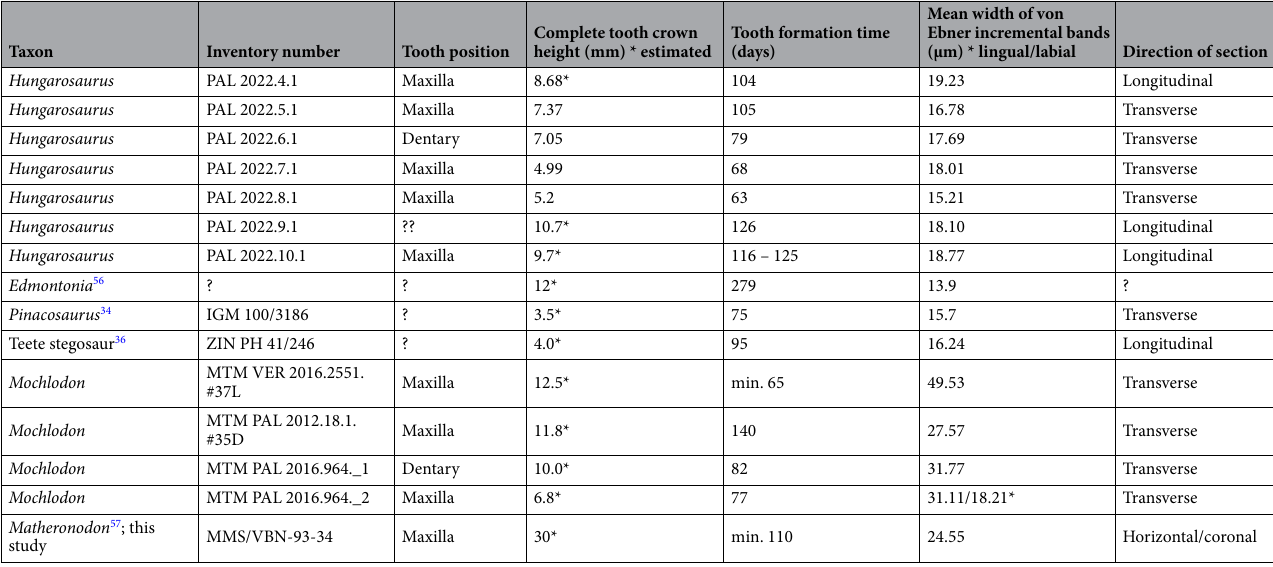
Table 2. Details of the specimens used for histological study, and tooth formation times counted on the Hungarian and some related